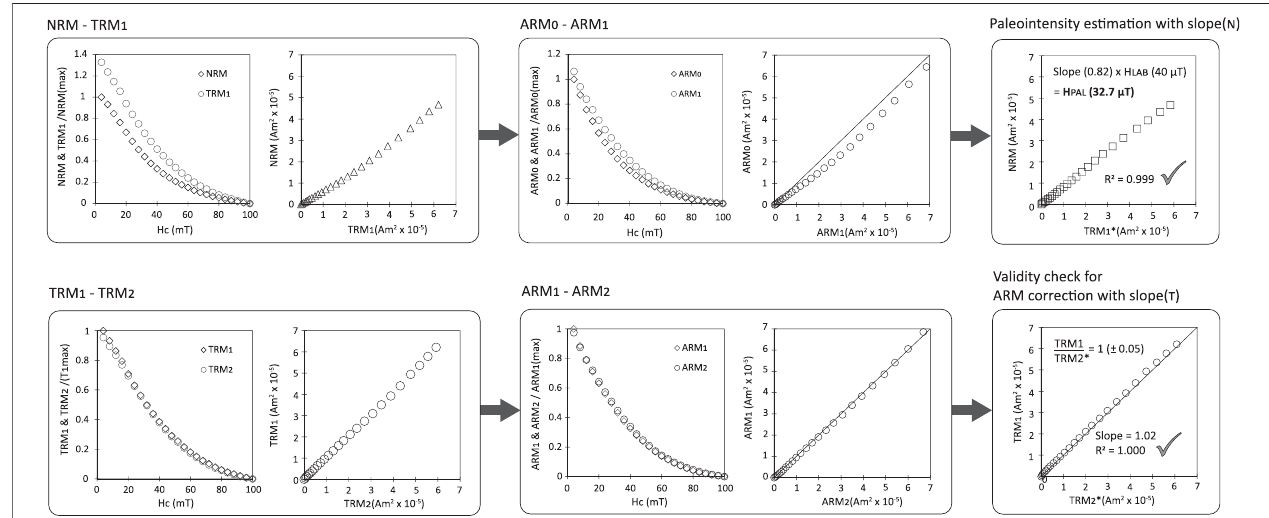
FIGURE 1 | Schematic view of the data analyses process for the Shaw-type experiment using a specimen from Mount Etna. Top row is the palaeointensity experiment, where any alteration to the TRM 1 demagnetisation spectra is corrected by multiplying by the ARM slope (ARM 0 /ARM 1 ) to produce TRM 1 *. Bottom row is a repeat experiment to test the validity of the ARM corrections. This ARM validity check uses additional remanence acquisitions (TRM 2 and ARM 2 ) and should produce a unit slope. Note that the values shown in these fi gures are after vectoral subtraction of the remanences at the maximum AF step.